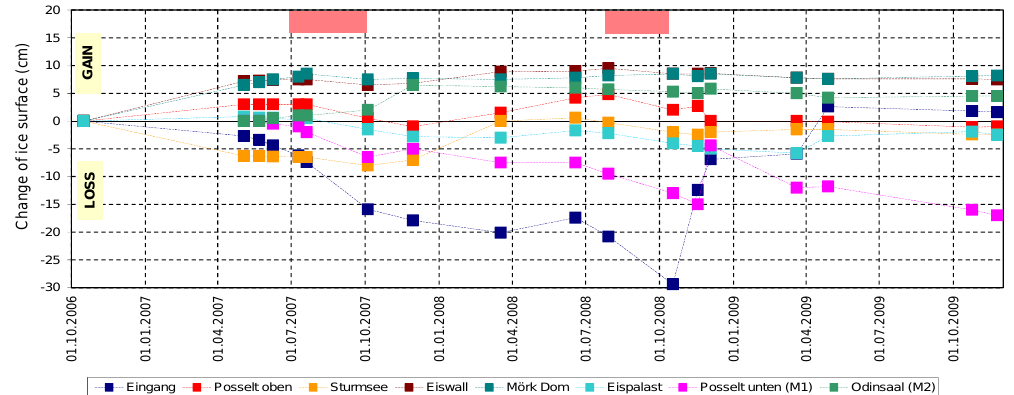
Fig. 4. Time series of accumulated ice surface changes of Eisriesenwelt ice body measured by manual stake readings within the period 1 October 2006 and 29 October 2009. The red bars mark summer/autumn periods with ice loss at almost all